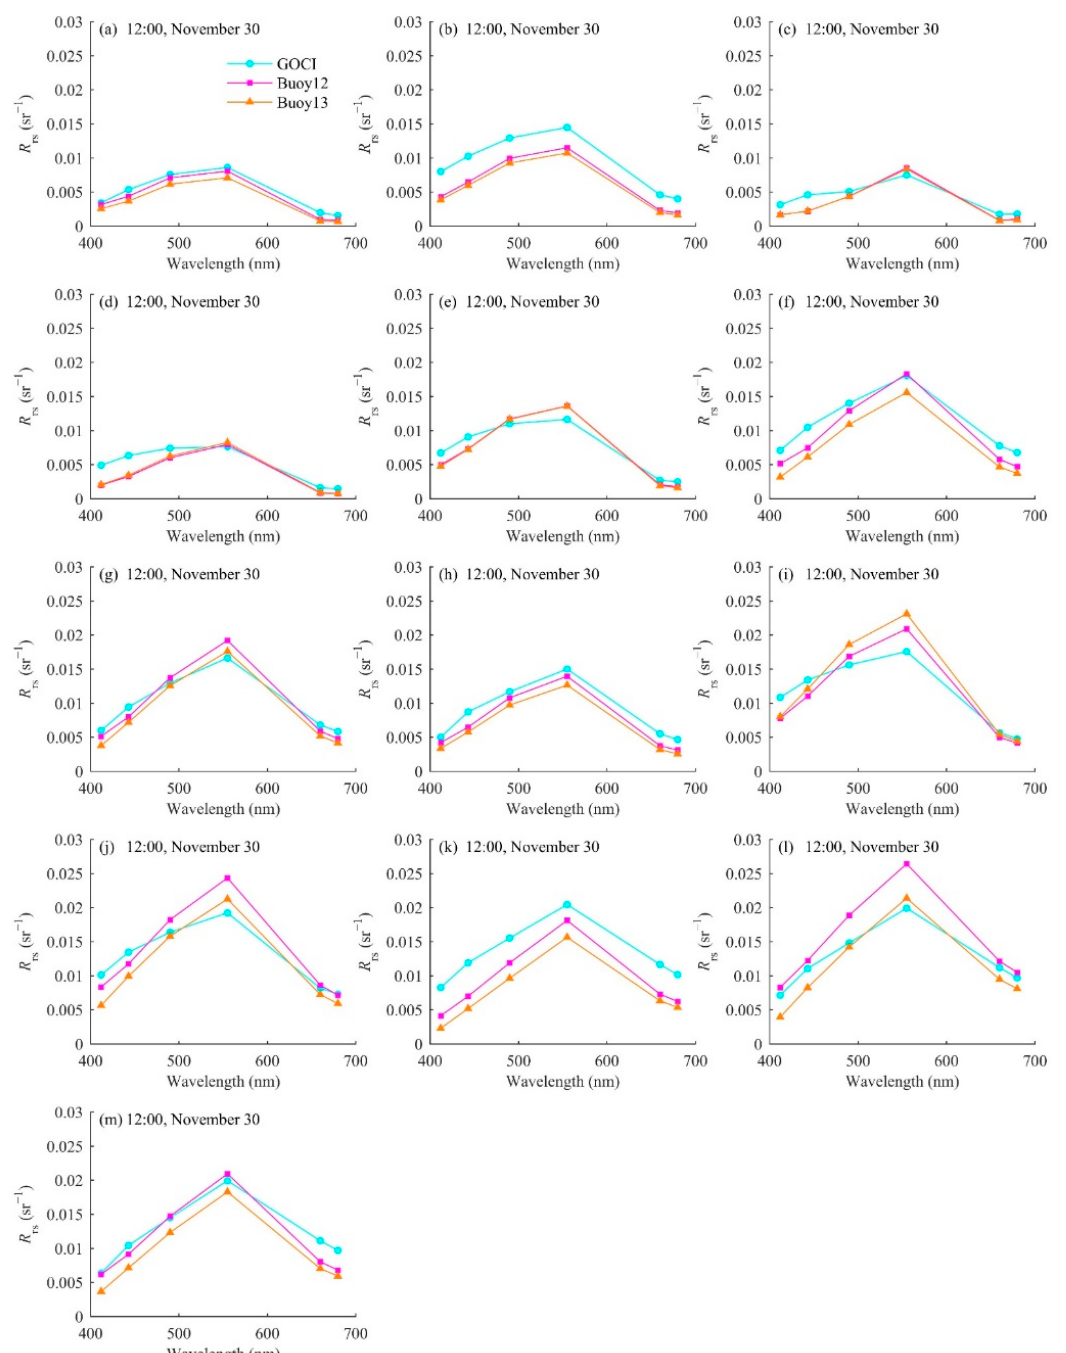
Figure 11. Comparison of R rs ( λ ) spectra between GOCI L2 estimations and buoy measurements at 412, 443, 490, 555, 660 and 680 nm. Note that Buoy12 and Buoy13 represent R rs of the water column between the first and second, and first and third radiometers,